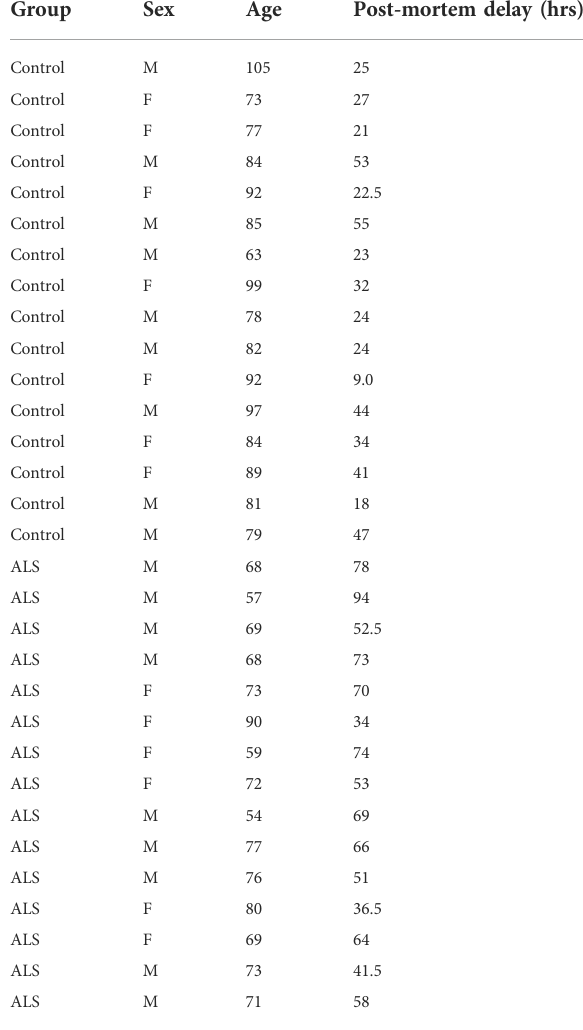
TABLE 1 Data for human post-mortem